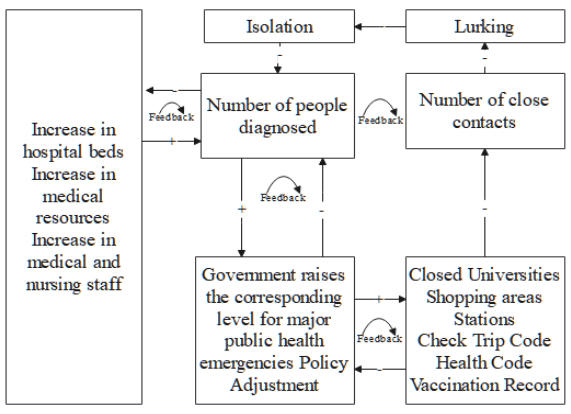
Figure 3. Interactions and feedback among various agents.